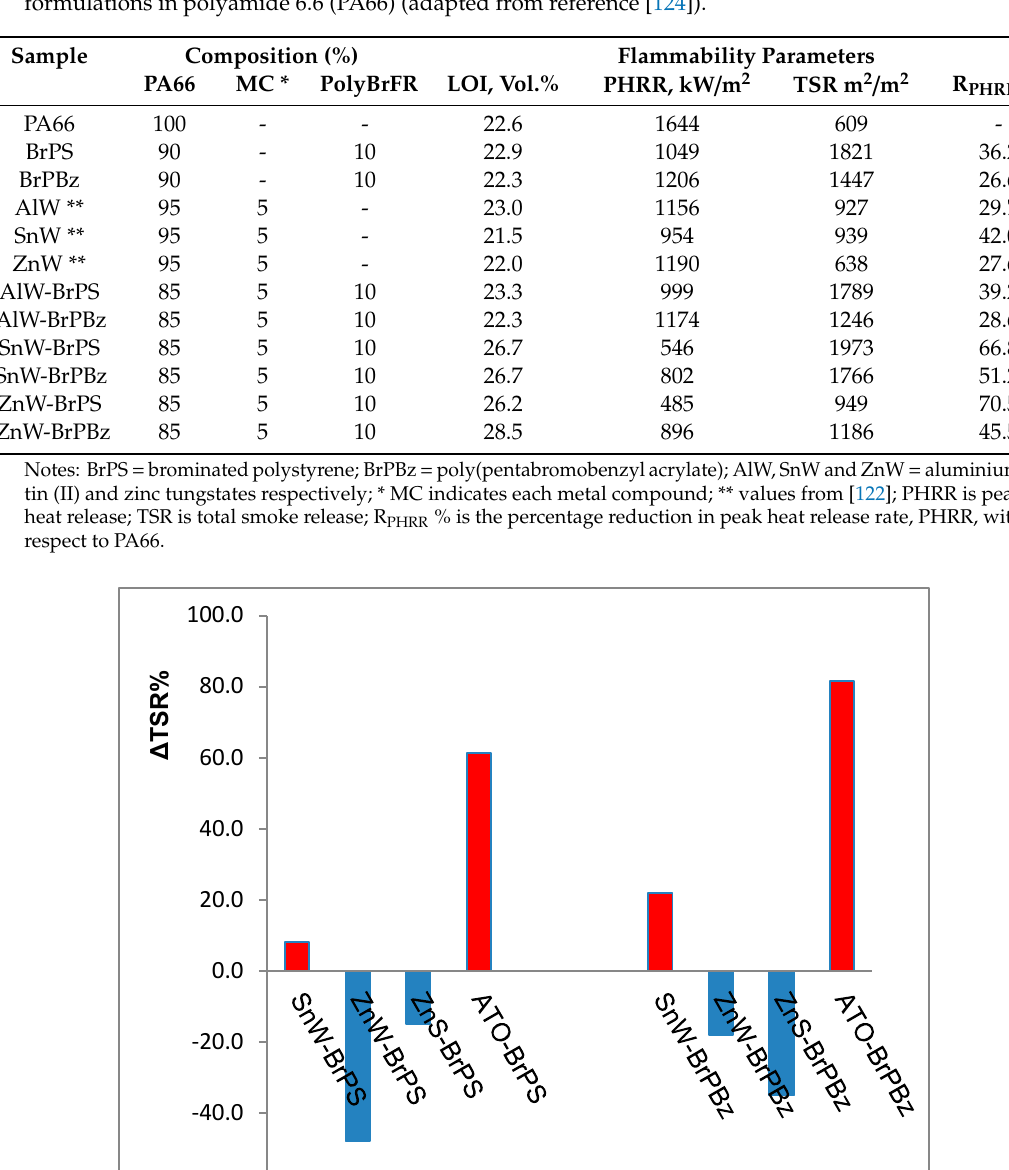
Table 4. Formulations and principal flammability parameters for tungstate / bromine-containing formulations in polyamide 6.6 (PA66) (adapted from reference [124]).